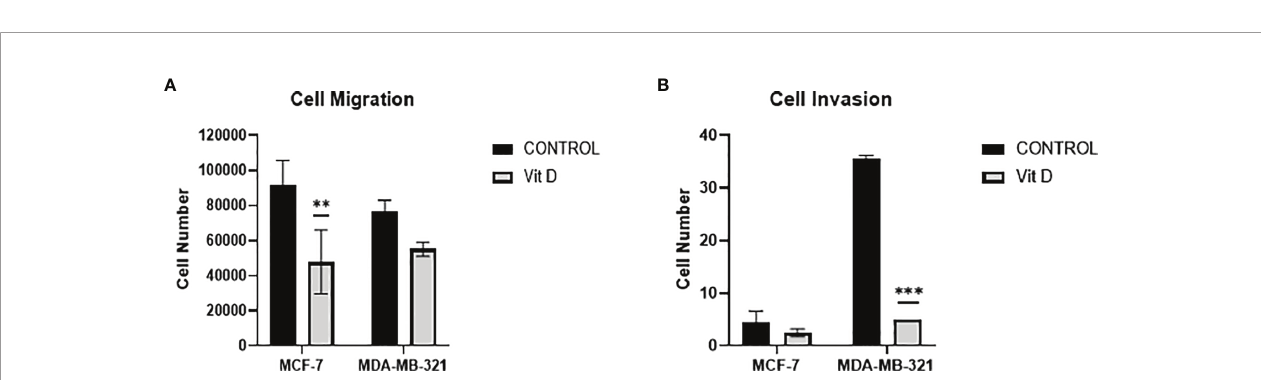
FIGURE 5 | Migration and invasion of MCF-7 and MDA-MB-231 cells after calcitriol treatment. (A) Cell migration assay displays the reduction of the number of migrating cells in both MCF-7 and MDA-MB-231 cells after treatment with calcitriol (10 µM). Cell invasion assay displays the reduction of the number of migrating cells in both MCF-7 and MDA-MB-231 cells after treatment with calcitriol (10 µM). (**), (***) represents statistically signi fi cant change ( p < 0.05) and ( p < 0.001), respectively in number of cells between treated and control (Ctrl) untreated cells at given time